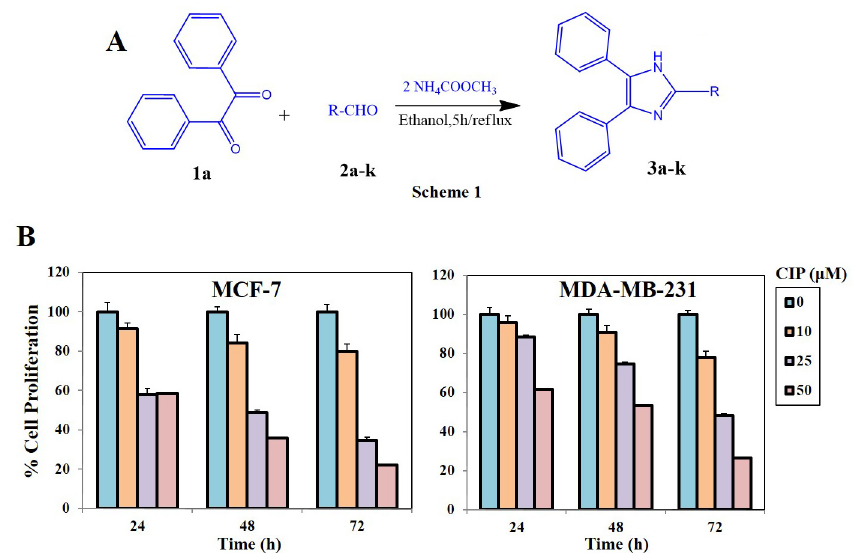
Fig 1. A, Schematic representation for the synthesis of imidazole based small molecules. B, Breast cancer cells (2.5 X 10 4 /mL, MCF-7 & MDA-MB-231) were plated in triplicate, treated with indicated concentrations (0, 10, 25 and 50 μ M) of CIP, and then subjected to MTT assay after 24, 48 and 72 h to analyse proliferation of cells. CIP suppresses the viability of various breast cancer cell lines in a dose- and time-dependent manner.